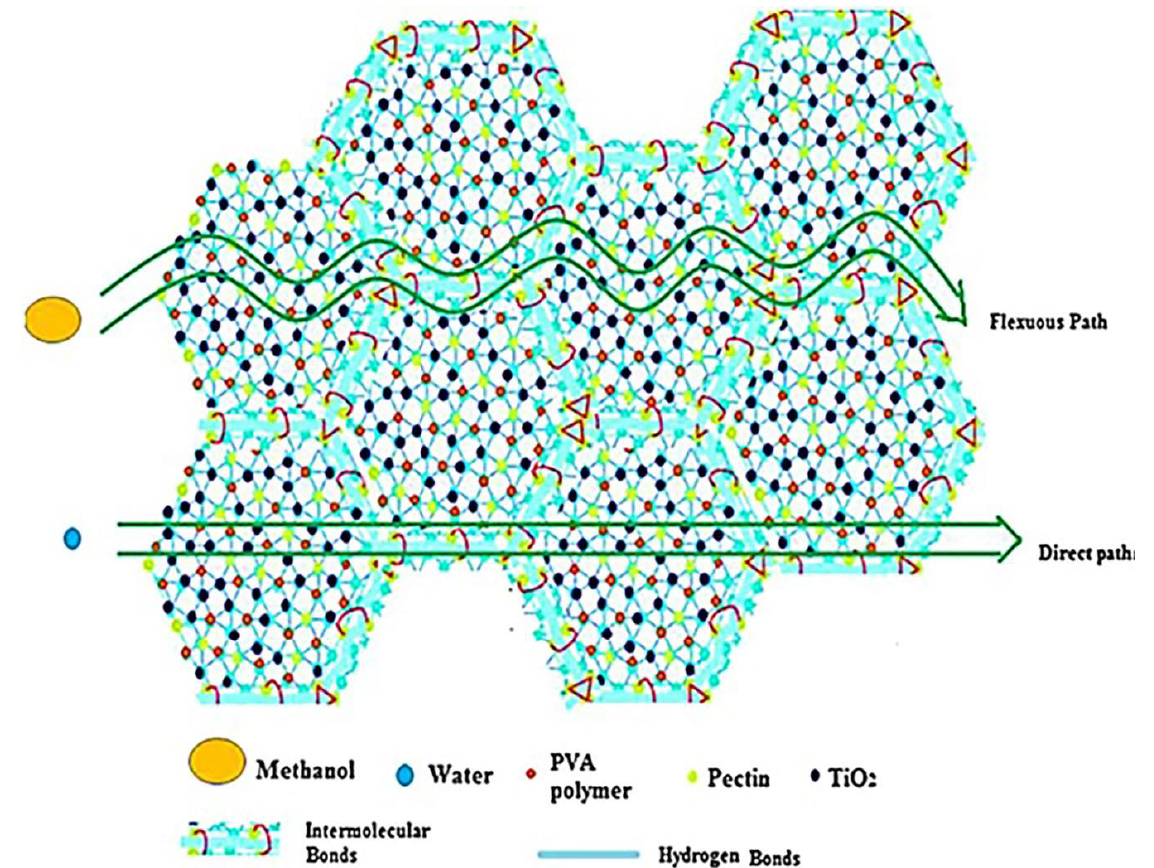
Figure 5. Scheme of facile proton transportation and constrained methanol transportation in PC- PVA/s-TiO 2 hybrid membranes [99]. PC-PVA/s-TiO 2 = pectin-poly(vinyl alcohol)/sulfonated tita- nium dioxide. PVA = poly(vinyl alcohol). Reproduced with permission from Elsevier.